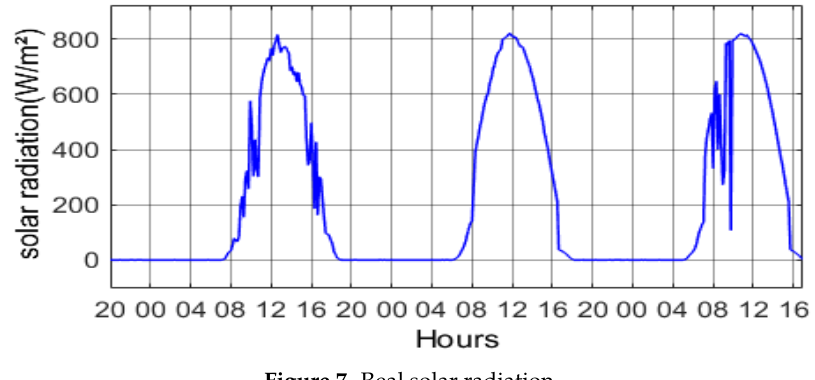
Figure 7. Real solar radiation.